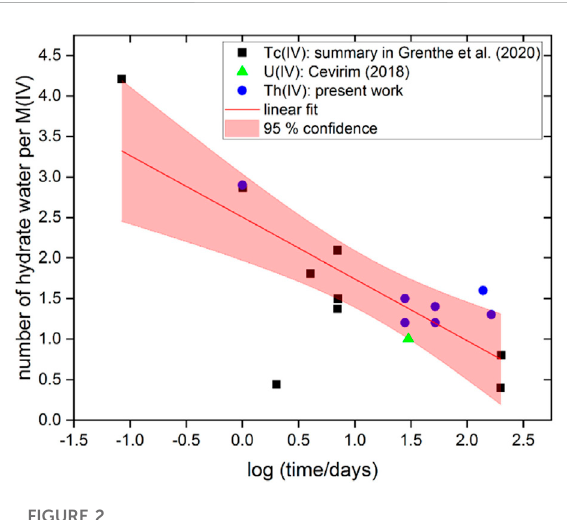
FIGURE 2 Evolution of the number of hydration waters in M(IV)O 2 (s, hyd) with time as reported in this work for Th or reported in the literature for U (Cevirim-Papaioannou, 2018) and Tc (Yalcintas et al., 2016; Grenthe et al., 2020). Figure modi fi ed after (Grenthe et al., 2020) (Tc chapter, prepared by B.